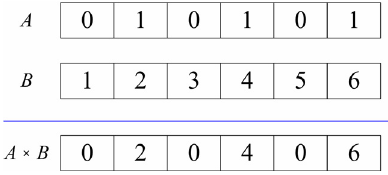
Fig. 7. Illustration of the redefined multiply operator (×)